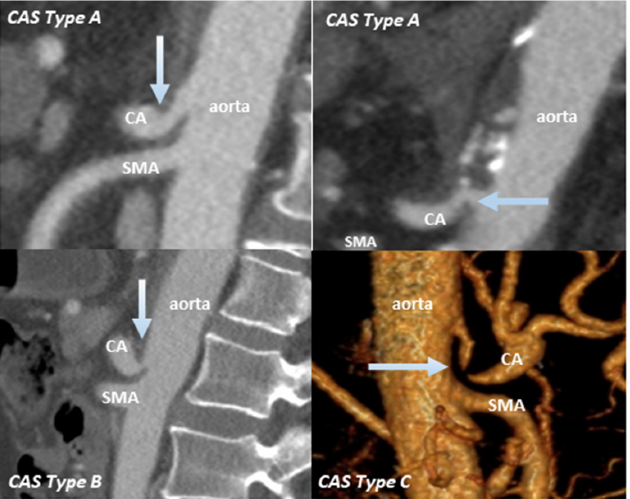
Figure 2. Celiac stenosis in four patients based on preoperative CT images. Arrows show the site of CAS (celiac artery stenosis); CA: celiac artery; SMA: superior mesenteric artery.